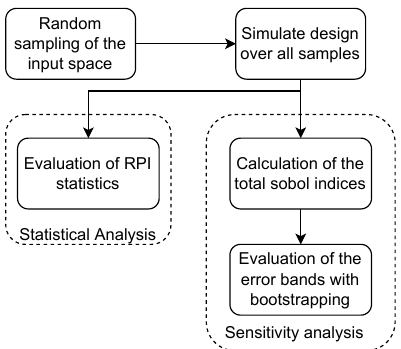
Figure 6. Flow diagram of the analyses used performed in this case